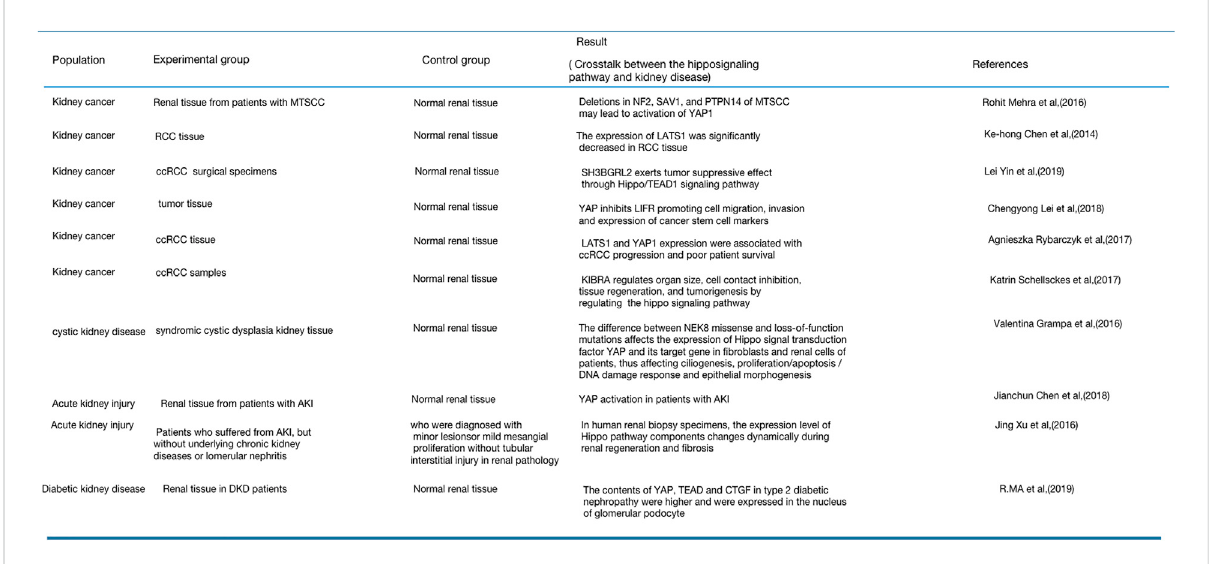
FIGURE 6 Expression of the Hippo signaling pathway in renal pathological